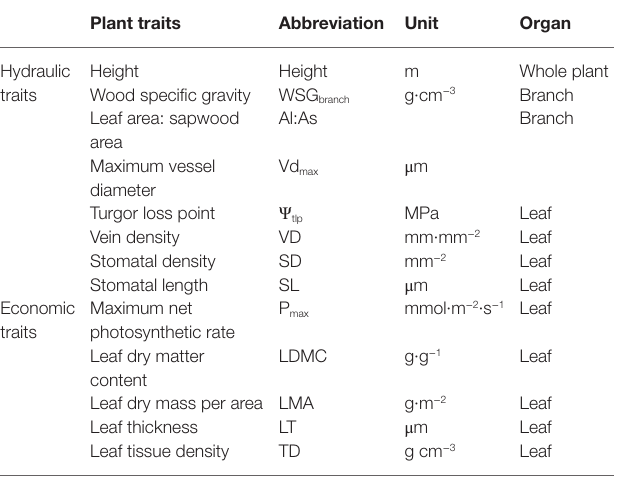
TABLE 1 | List of 13 functional traits measured at the branch, leaf, and whole- plant level for this study with corresponding abbreviations and units. Plant